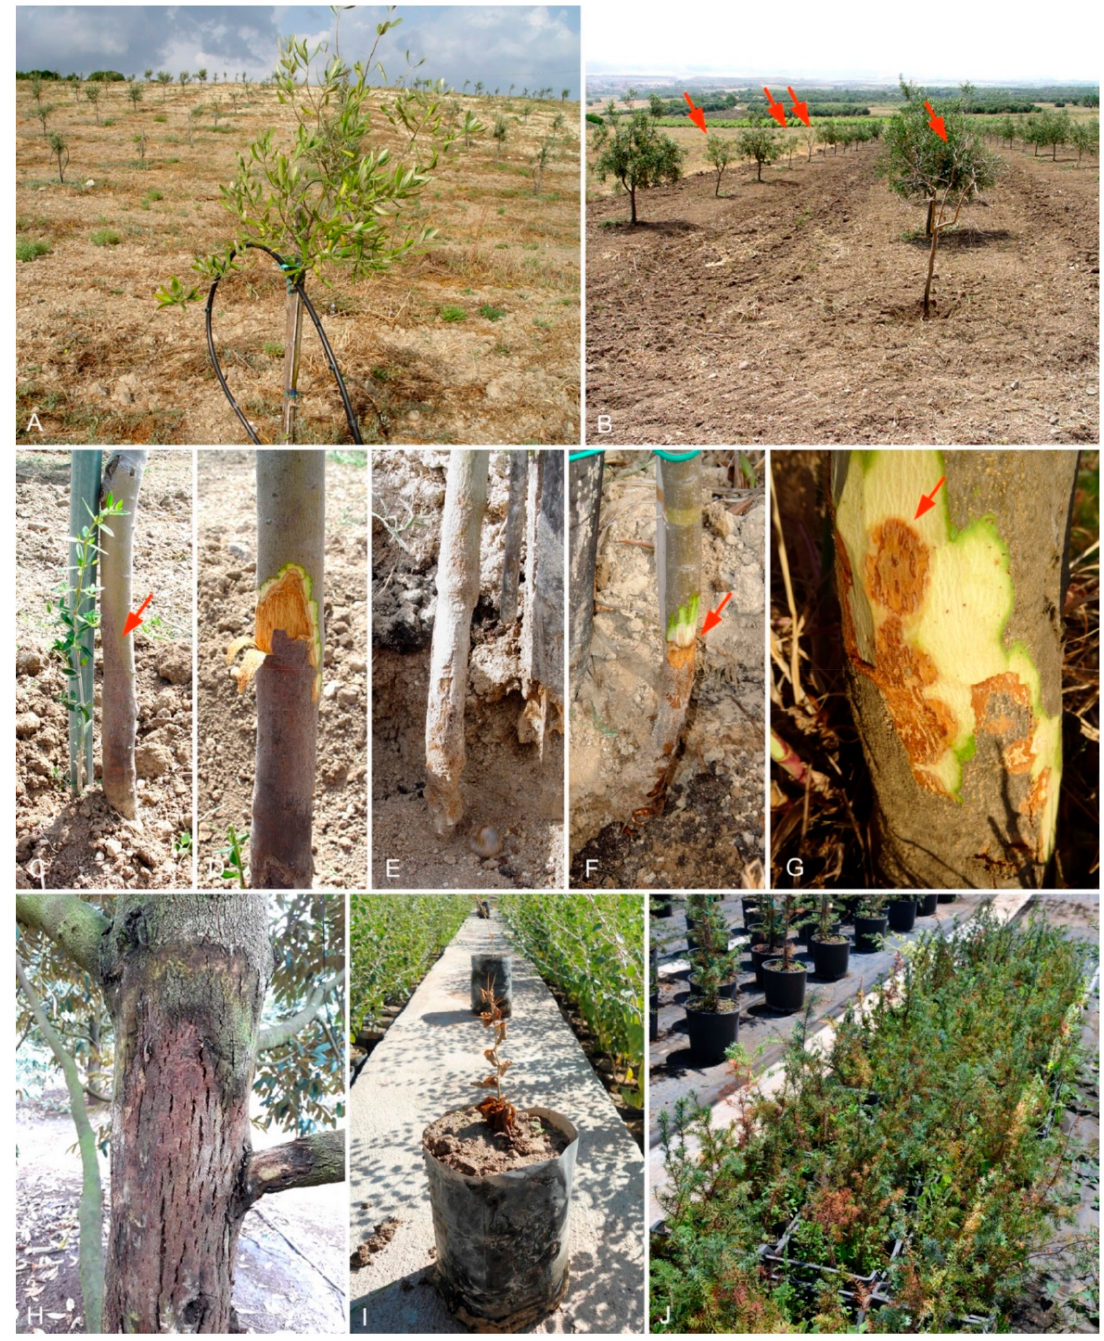
Figure 1. Disease symptoms caused by Phytophthora heterospora on Olea europaea in Italy ( A – G ): ( A ) 3- to 4-year-old trees showing chlorosis and increased transparency of the crown; ( B ) a 5-year-old plantation with dying and dead trees; ( C ) necrotic outer bark lesion on the lower part of the stem (arrow); ( D ) orange-brown and flame shaped lesions on the stem; ( E , F ) necrotic bark lesions girdling the collar; ( G ) single-spot bark lesions on the main stem (arrow). ( H ) Stem canker and scaffold branches on a mature tree of Durio zibethinus in Vietnam. ( I ) A dead 1-year-old seedling of Ziziphus spina-christi in a nursery in Iran. ( J ) Two-year-old Juniperus oxycedrus seedlings showing dieback in a nursery in